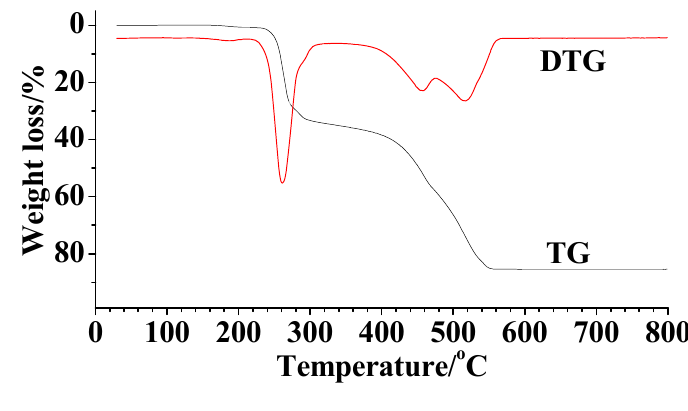
Figure 2. The TG-DTG curve of complex 1.